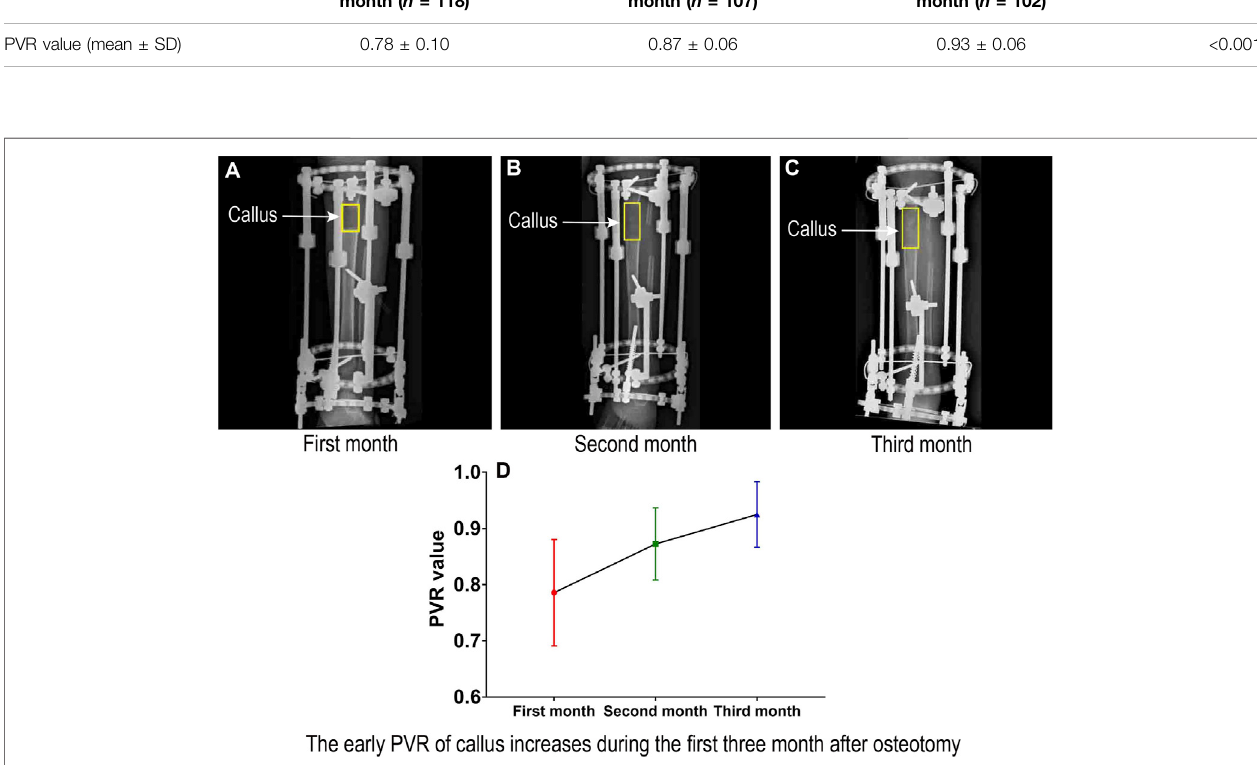
FIGURE 3 | Early PVR of the regenerated callus during distraction